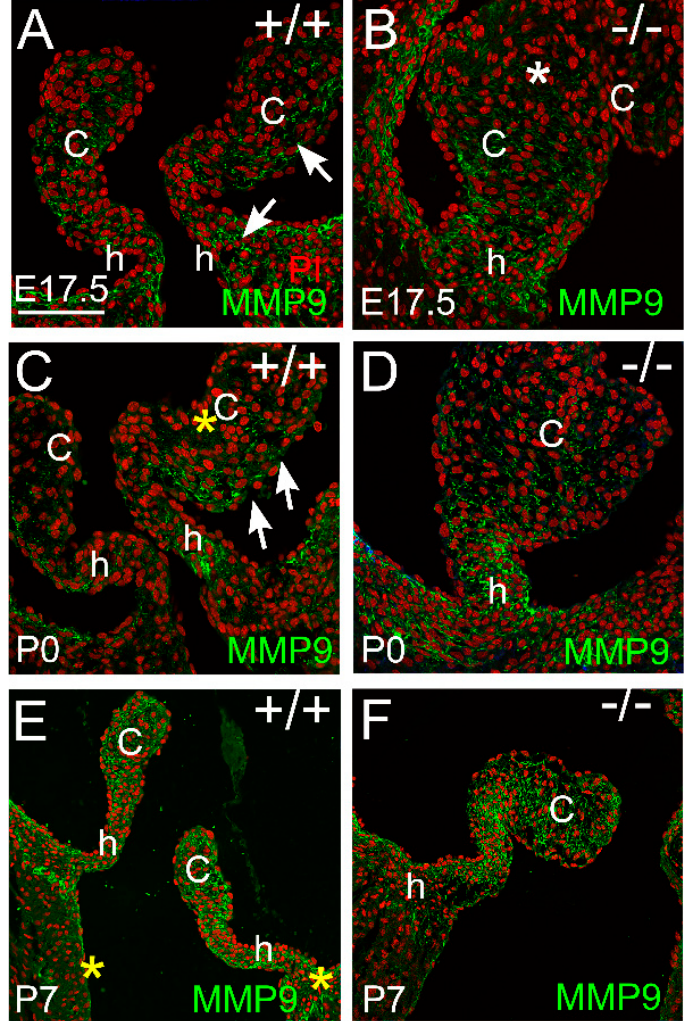
Figure 5. MMP9 is localized in valvular interstitial cells of developing cardiac valve cusp and hinge regions. MMP9 immunolocalization (green) at embryonic day 17.5 (E17.5; A , B ), postnatal day 0 (P0; C , D ), and postnatal day 7 (P7; E , F ) in wild type (+/+; A , C , E ) and Adamts5 − / − PV ( − / − ; B , D , F ). c—valve cusp; h—valve hinge region. Red—propidium iodide. White asterisk—localization of MMP9 throughout the VICs, yellow asterisk-region of VICs devoid of MMP9 localization. Bar in ( A ) = 150 μ m and applies to ( B – F ).